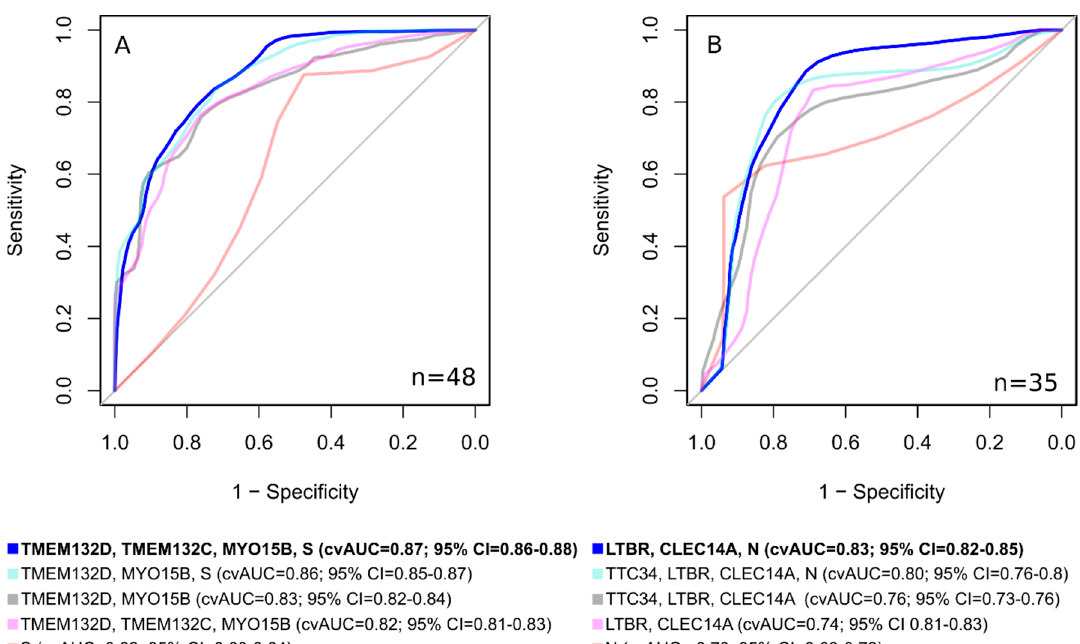
Figure 5. ROC curves, cross-validated area under the curve (cvAUC) for breast cancer NACT sensitivity classifiers for TN ( A ) and luminal B subtypes ( B ), consisting of separate clinical, separate molecular epigenetic, and combined predictors.